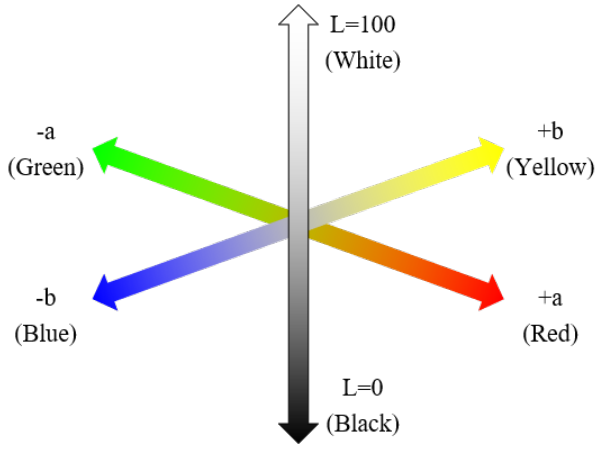
Figure 4. Axes of the CIE L*a*b* color